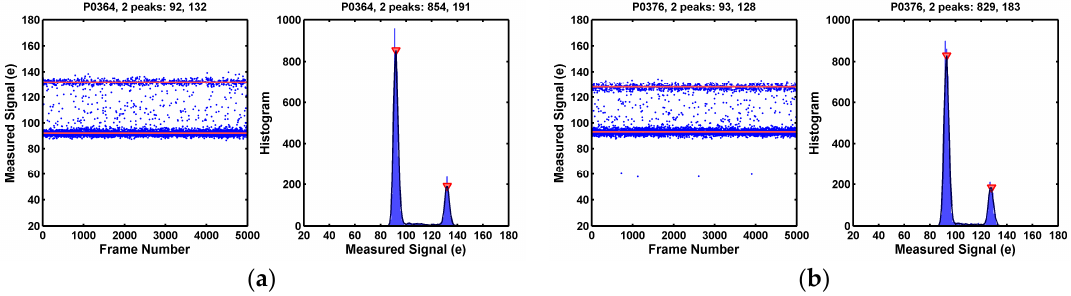
Figure 9. ( a , b ) Two example pixels showing 2 identifiable histogram peaks, which are the degenerated cases of the 3-peak pixels. These pixels are considered as having single RTN trap. The mechanism causing the disappearance of the third peak is discussed in Section 8.1.